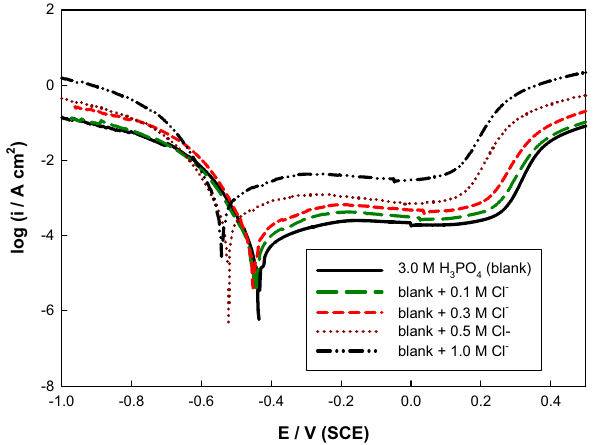
Figure 3. Potentiodynamic polarization curves of Mo in 3.0 M H 3 PO 4 containing different concentrations of Cl − at 298 K.